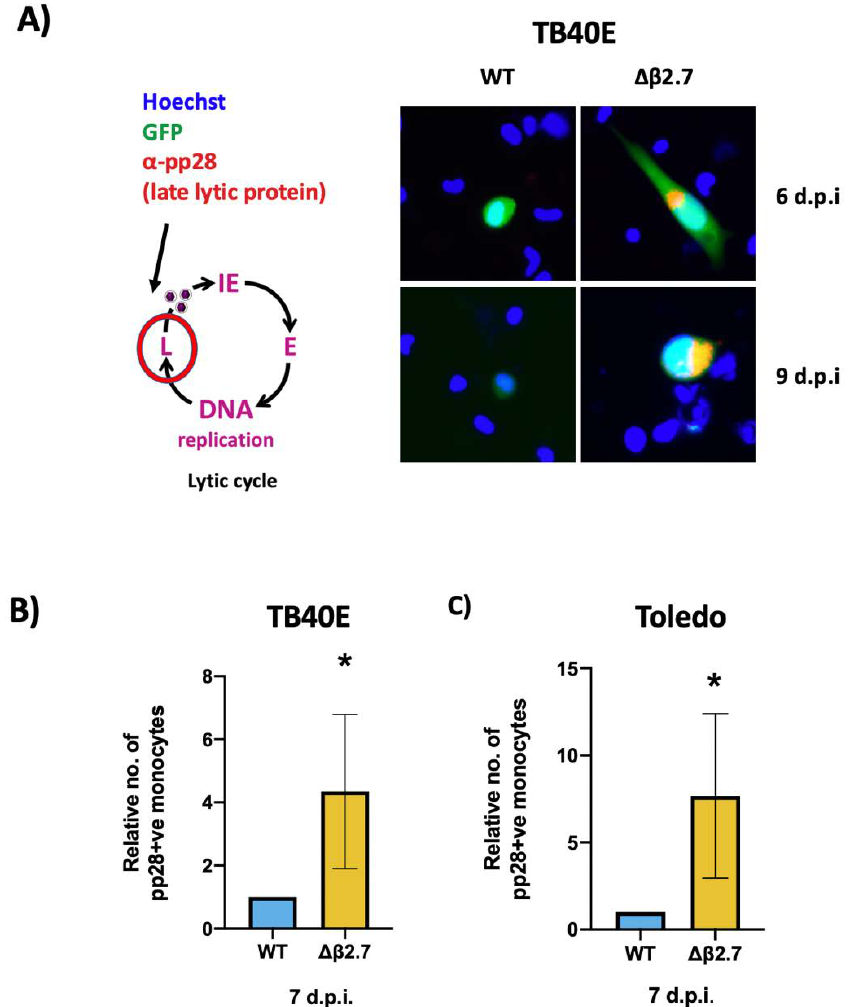
Figure 3. Deletion of β 2.7 leads to increased expression of the late lytic protein pp28 in infected monocytes. ( A ) CD14+ monocytes were infected with WT SV40-GFP TB40E (WT) or ∆ β 2.7 SV40-GFP TB40E ( ∆ β 2.7) virus at an MOI of 5 and fixed and stained for the late lytic protein, pp28, at 6 and 9 d.p.i. Images were captured using a 20 × lens. ( B , C ) CD14+ monocytes were infected with WT or ∆ β 2.7 viruses from ( B ) TB40E or ( C ) Toledo strains at an MOI of 5. At 7 d.p.i, cells were fixed and immunostained for pp28. Graph shows the mean number of pp28-positive monocytes relative to WT over 3 independent biological repeats. Error bars show standard deviation. Significance was calculated using a one-tailed Student’s t -test. * = p <